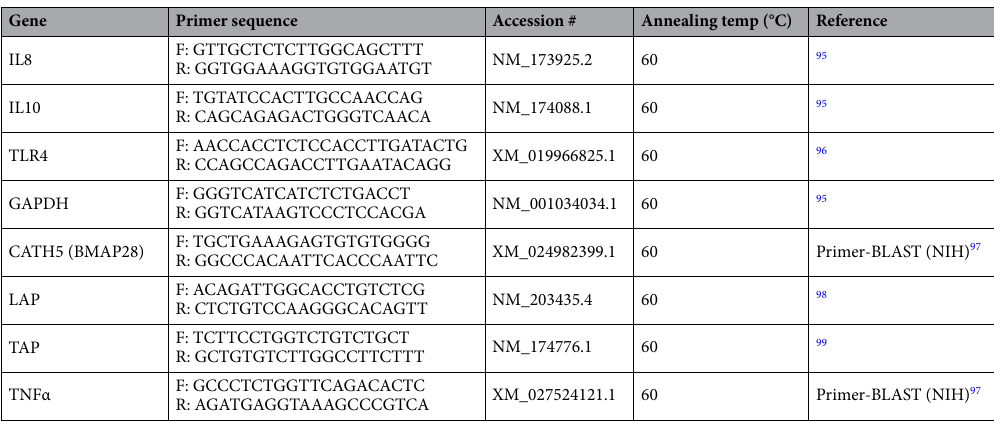
Table 2. Bovine primers used for mRNA relative quantification